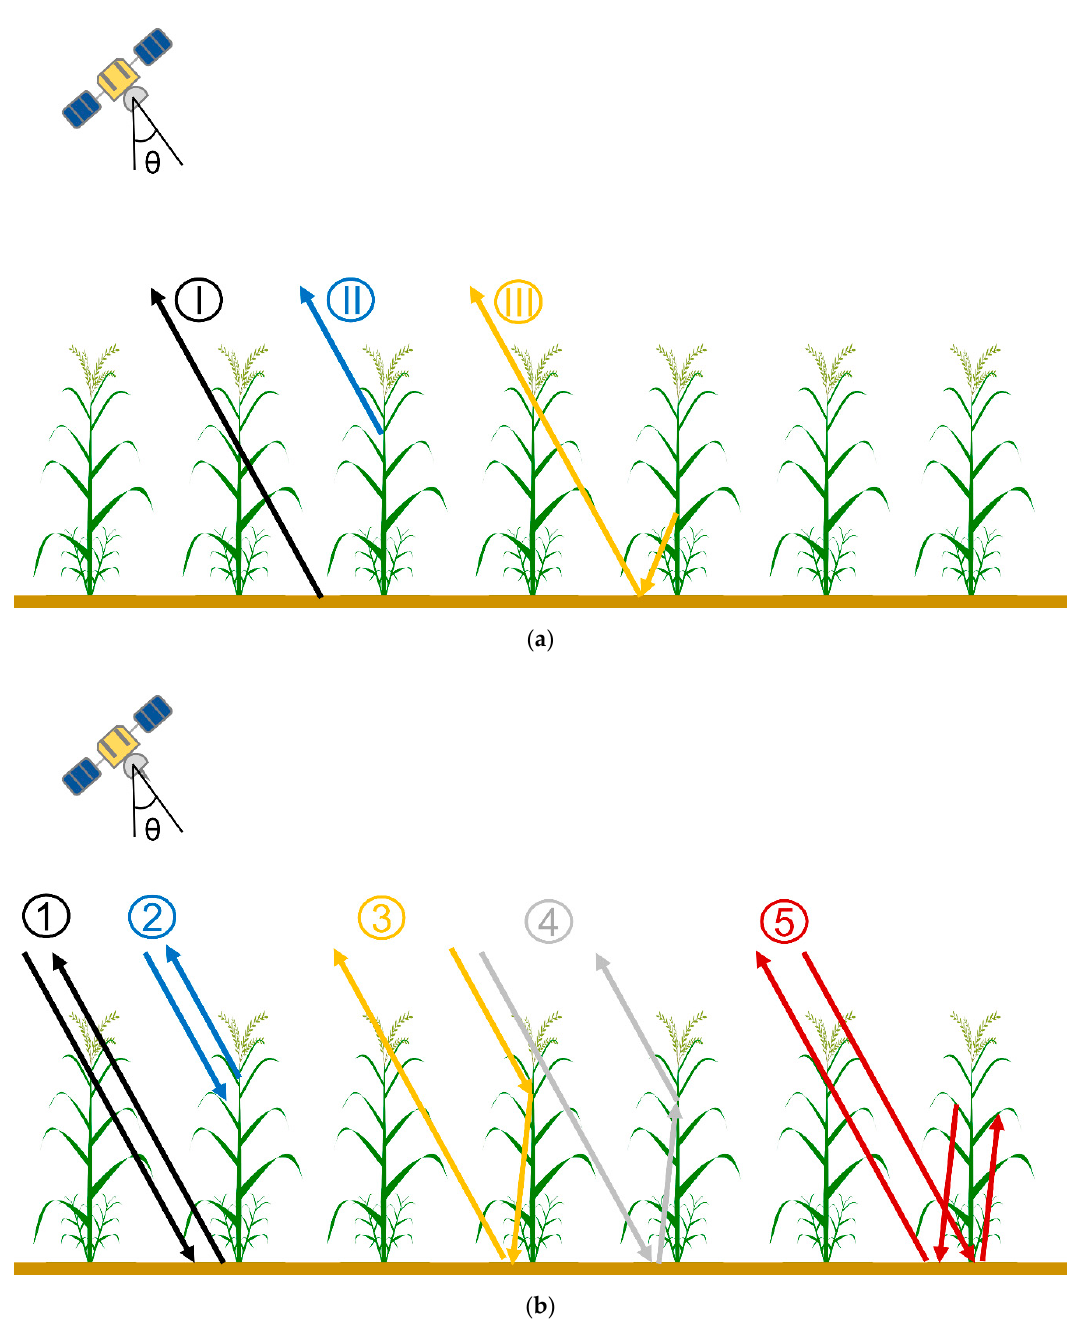
Figure 1. Mechanisms for microwave land surface emission ( a ) and backscattering ( b ). ( a ) Direct emission by soil including one-way attenuation by canopy (I—black), direct upward emission by plants (II—blue), vegetation emission downward followed by reflection (III—orange); ( b ) Single-scattering contributions in a vegetation canopy: direct backscattering from soil including two-way attenuation by canopy (1—black), direct backscattering from vegetation (2—blue), vegetation / ground scattering (3—orange), ground / vegetation scattering (4—grey), ground / vegetation / ground scattering (5—red). Adapted from [42].